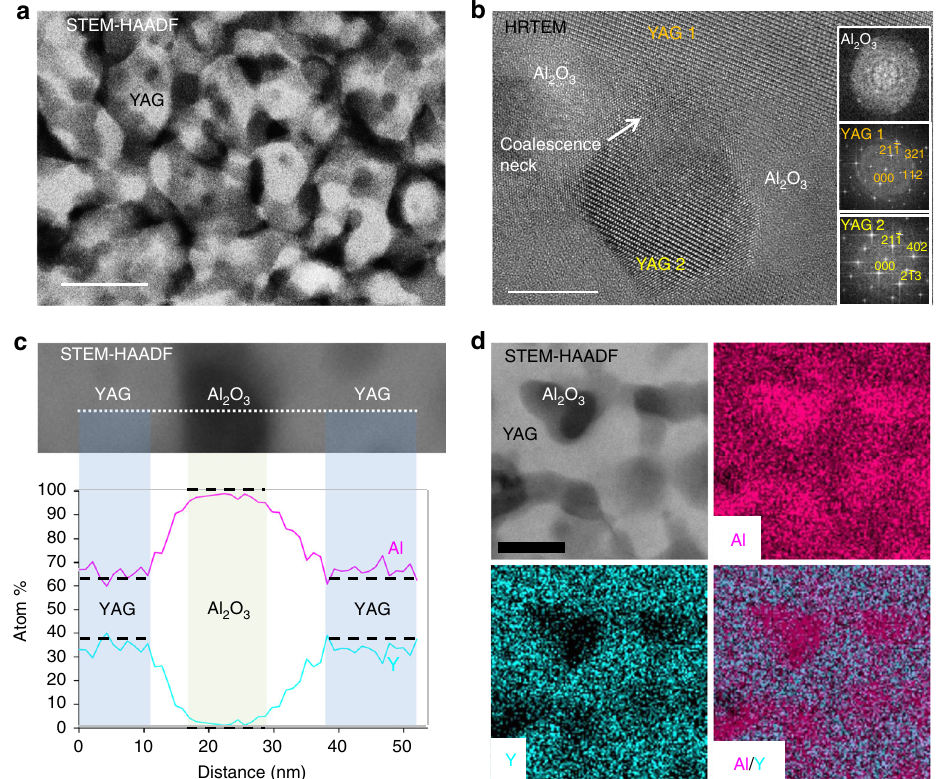
Fig. 3 TEM study of the YAG-Al 2 O 3 ceramic nanostructure. a STEM-HAADF image of the YAG-Al 2 O 3 ceramic showing an interconnected 3-D network of the YAG crystals (bright phase) separated by Al 2 O 3 areas (dark phase). The scale bar corresponds to 50 nm. b HRTEM micrograph of the same YAG- Al 2 O 3 ceramic showing a typical coalescence neck between two particles (YAG 1 and YAG 2) oriented along the 351 respectively (scale bar corresponds to 10 nm). The micrograph and the FFT patterns embedded show that the 211 parallel (small rotation deviation of 6°). STEM-EDX cationic c composition pro fi le and d elemental maps showing that the bright phase observed by STEM- HAADF (scale bar corresponds to 25 nm) can be assigned to YAG and the dark phase to Al 2 O